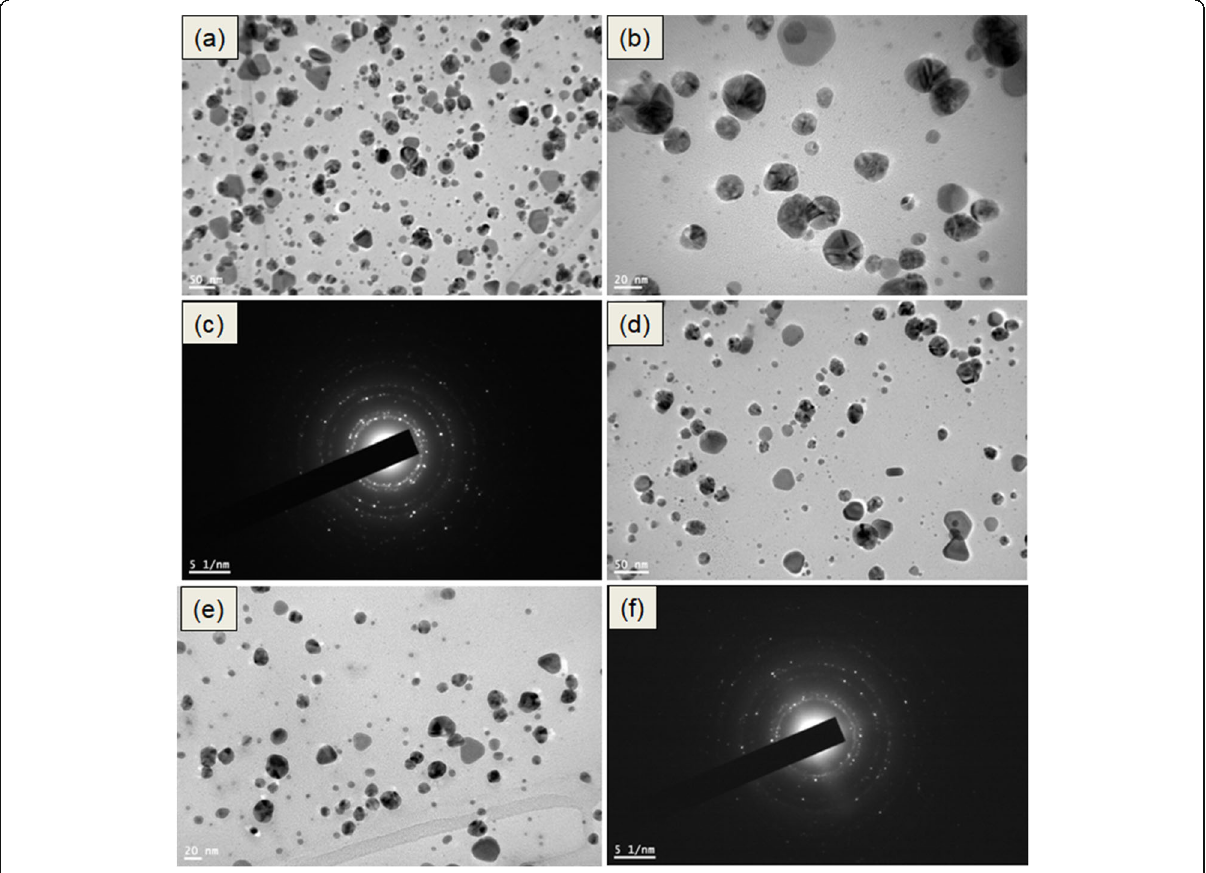
Fig. 3 Transmission electron microscopy images of synthesized silver nanoparticles — 1:6 SS-AgNPs ( a – c ) and 1:8 SS-AgNPs ( d – f